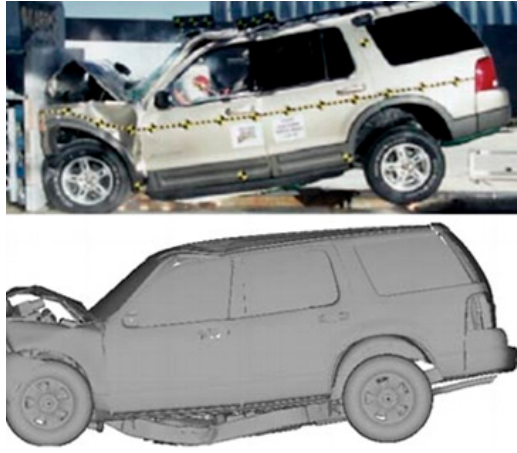
Figure 2. Deformations of the car in test and simulation.